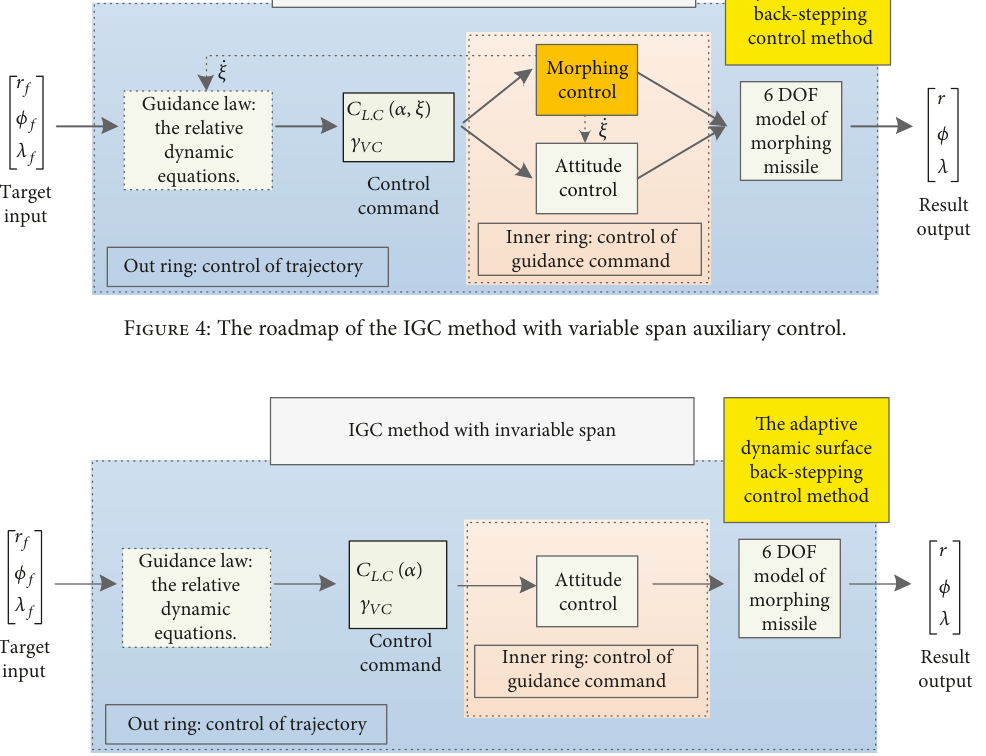
Figure 5: The roadmap of the IGC method with invariable